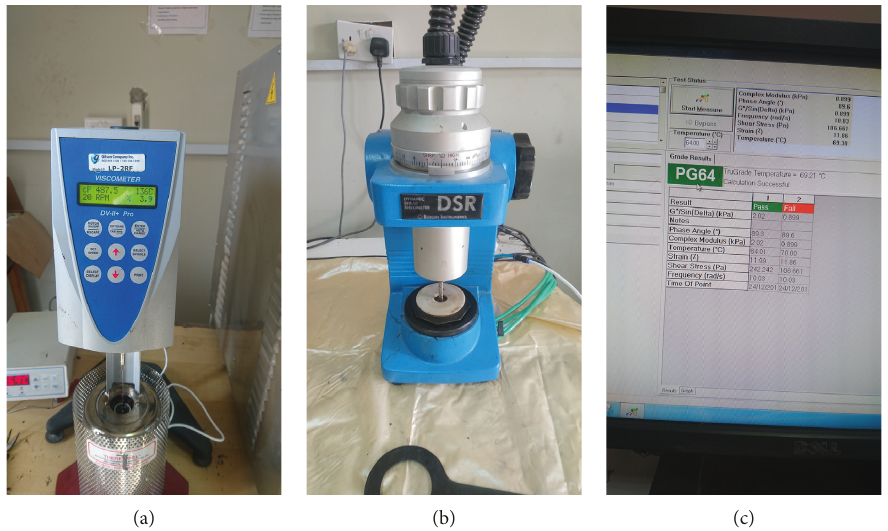
Figure 1: Photograph for asphalt cement PG test.